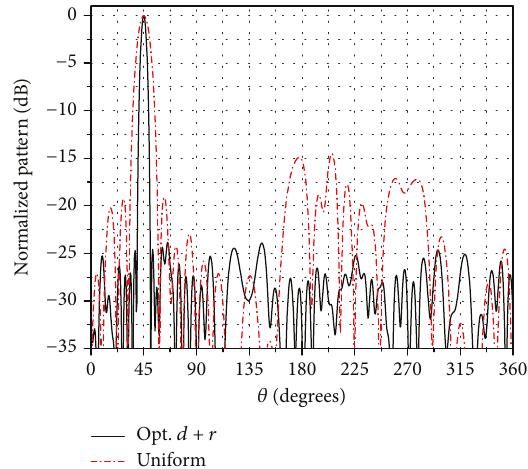
Figure 7: Comparison of normalized power patterns generated by the proposed C-BFN con fi guration with a uniform and nonuniform concentric ring array, optimizing d and r .